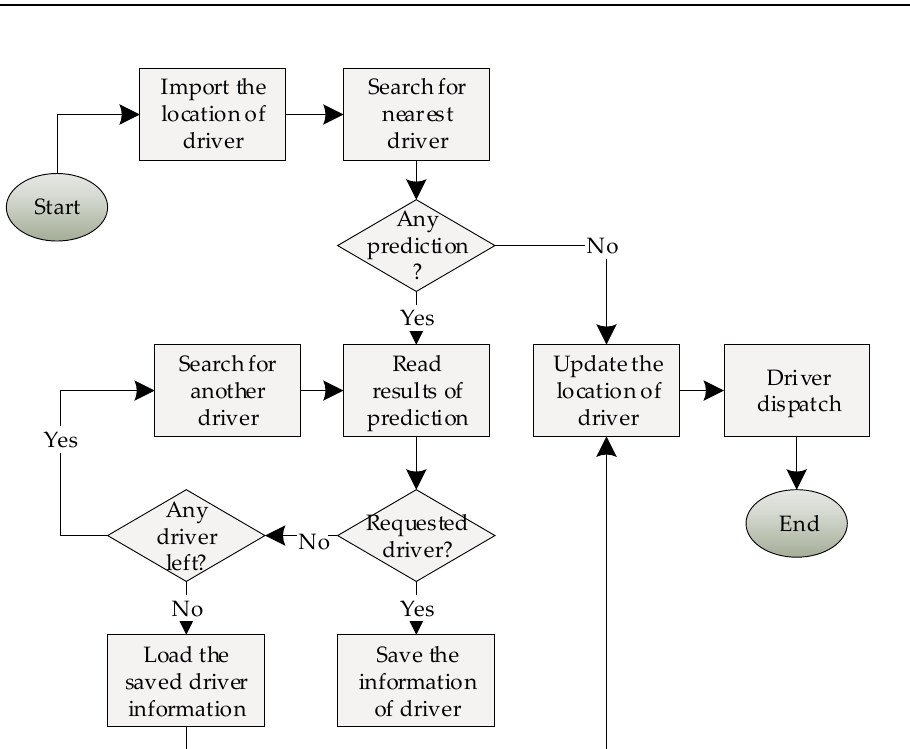
Figure 6. Ride-hailing system